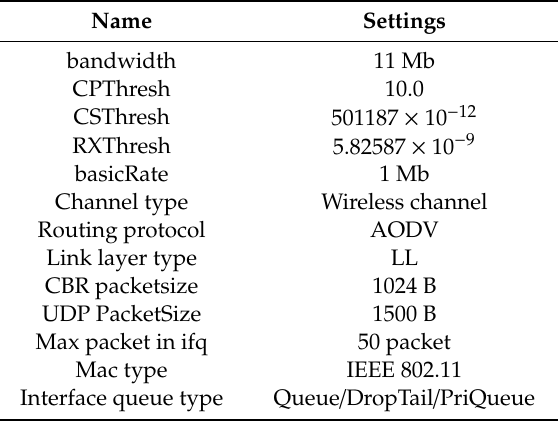
Table 1. Network